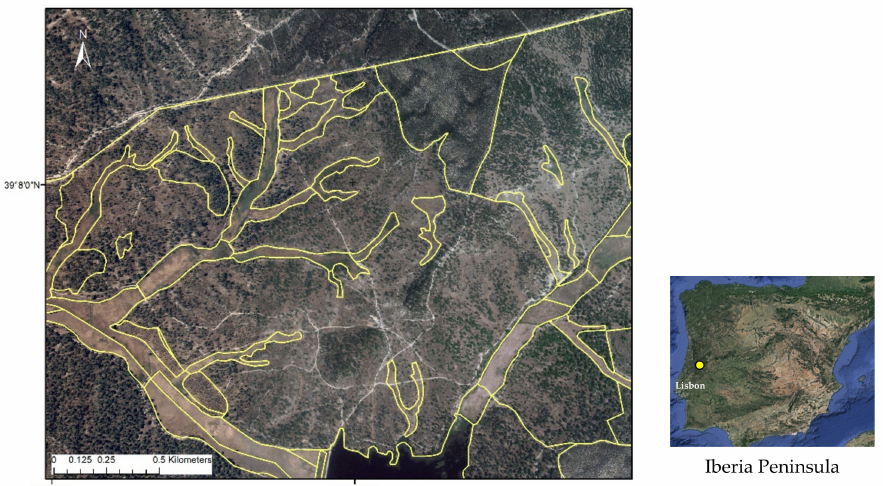
Figure 1. The study area location is approximately 100 km northeast of Lisbon, Herdade da Ma- choqueira do Grou (HMG), yellow marker on the right image. The Pleiades image is shown in a real color combination (red, green, and blue). In this area, the dominant vegetation cover types are cork oak (spread throughout the area), stone pine (southwest), and eucalyptus (north-center). The vegetation cover map (yellow line) was provided by the property